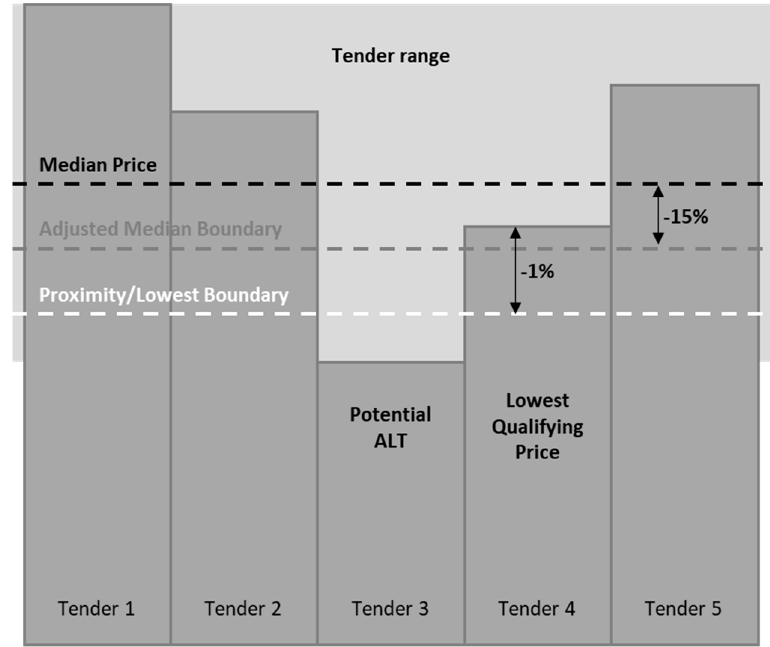
Figure 4. Identi fi cation of potential ALTs [34]. Figure 4. Identification of potential ALTs